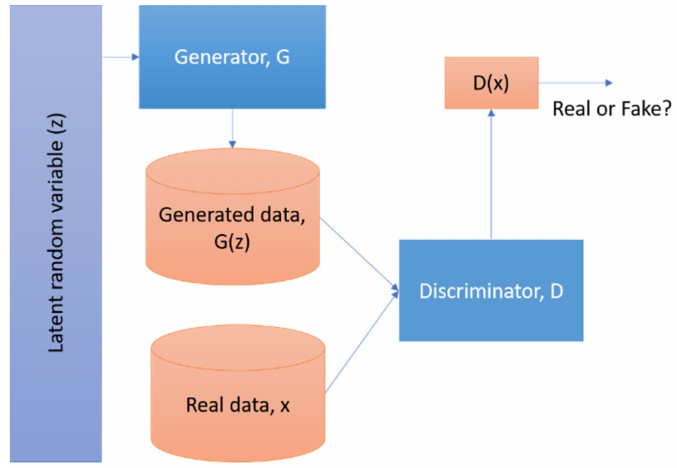
Figure 3. Schematic diagram of a basic Generative Adversarial Network. Latent variable or noise term is used in the generator part to generate the output, whereas the discriminator part compares the generated and original data to distinguish whether it is real or